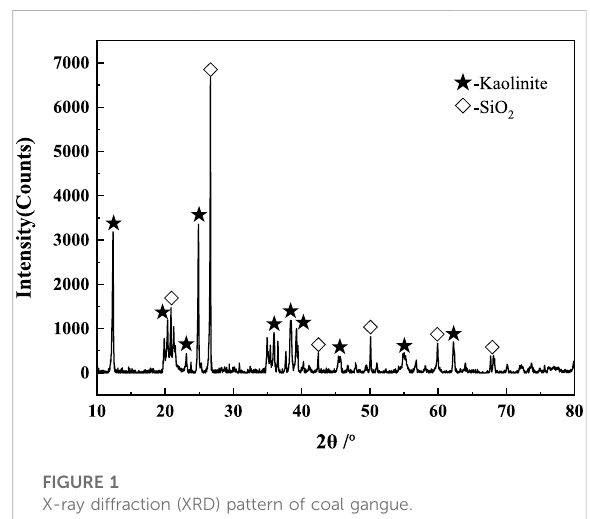
FIGURE 1 X-ray diffraction (XRD) pattern of coal gangue.